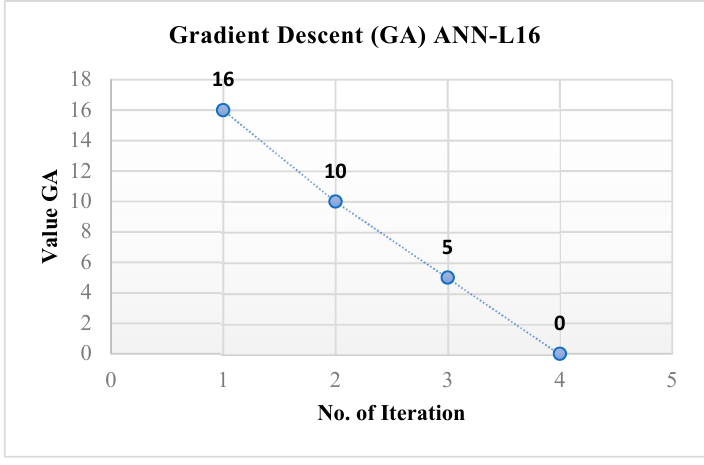
Figure 5. GA for ANN-L16-training part (UCP).